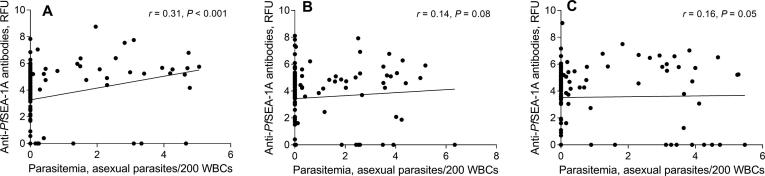
Effects of parasitemia from birth to 6 months of age on anti-PfSEA-1A antibody levels at 6 months of age according to tertiles (A: low, B: middle, and C: high) of cord blood anti-PfSEA-1A antibody levels. Anti-PfSEA-1A antibody levels and parasitemia were natural log-transformed. Spearman correlation analysis was used to examine the correlation between parasitemia and anti-PfSEA-1A antibody levels in each tertile. The interaction term between tertiles of cord blood anti-PfSEA-1A antibody levels and parasitemia from birth to 6 months of age, had a significant effect on anti-PfSEA-1A antibody levels (P value = 0.043).